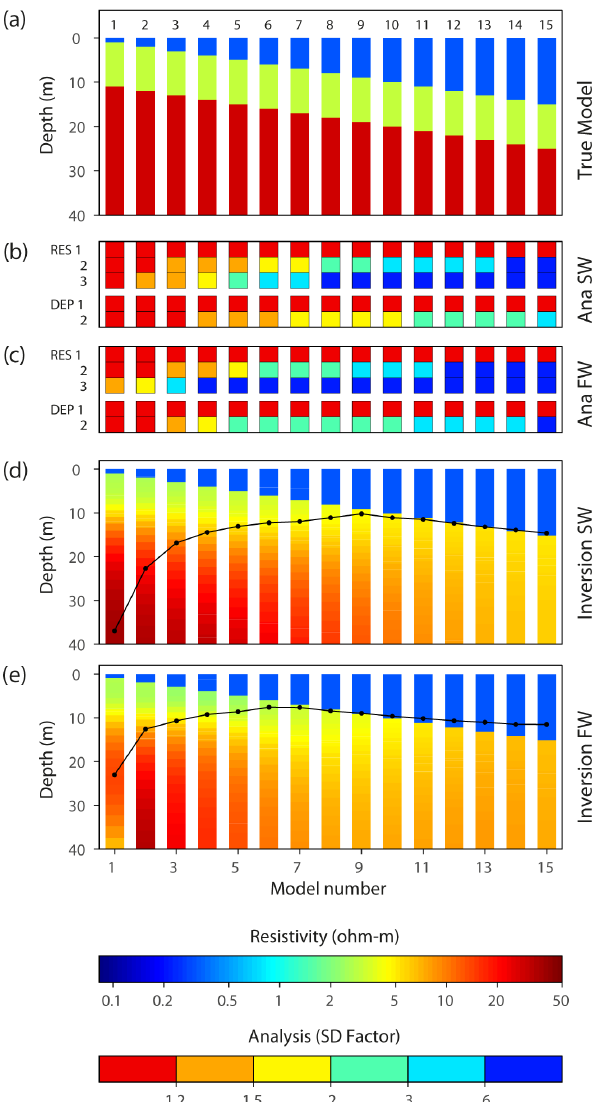
Figure 2. (a) True model. The number on top of each model bar states the water depth (thickness of first layer). (b, c) Model pa- rameter analyses of the true models, stated as a standard deviation factor, for the SW-FloaTEM and FW-FloaTEM systems. (d, e) In- version results for SW-FloaTEM and FW-FloaTEM systems. The black line shows the DOI.